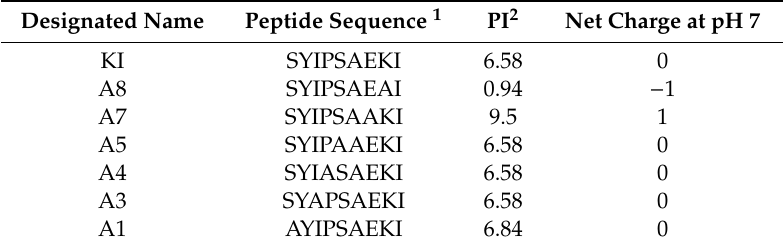
Table 1. Alanine substitutions along the SYIPSAEKI peptide